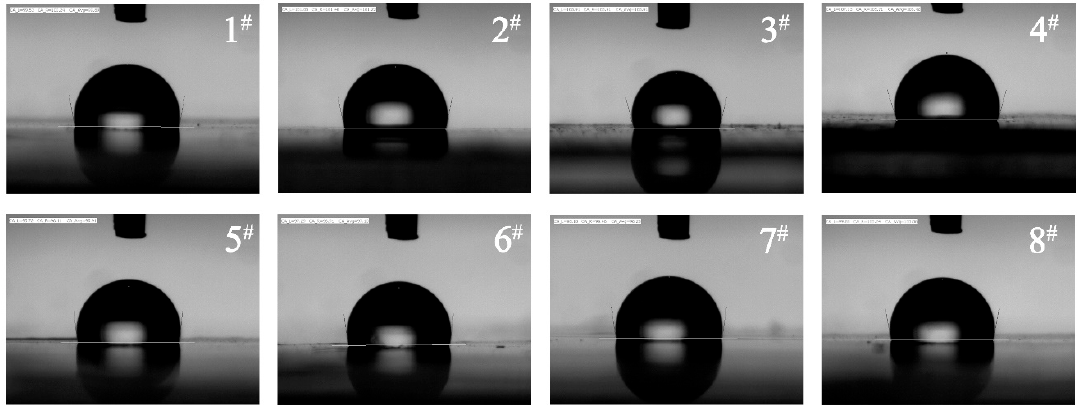
Figure 4. Water contact angle of eight composite films